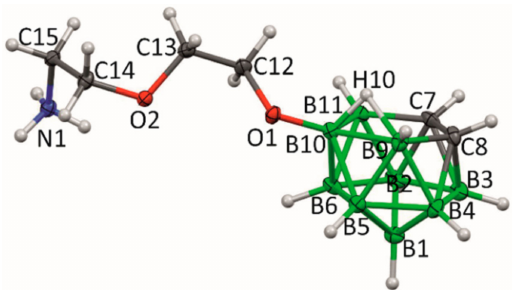
Figure 2. The molecular structure of 2 , ORTEP diagram, 40% probability level. Selected interatomic distances [Å] and angles [ ◦ ]: O1 C12 1.4400(18), O1 B10 1.459(2), N1 C15 1.490(2), B1 B4 1.762(3),